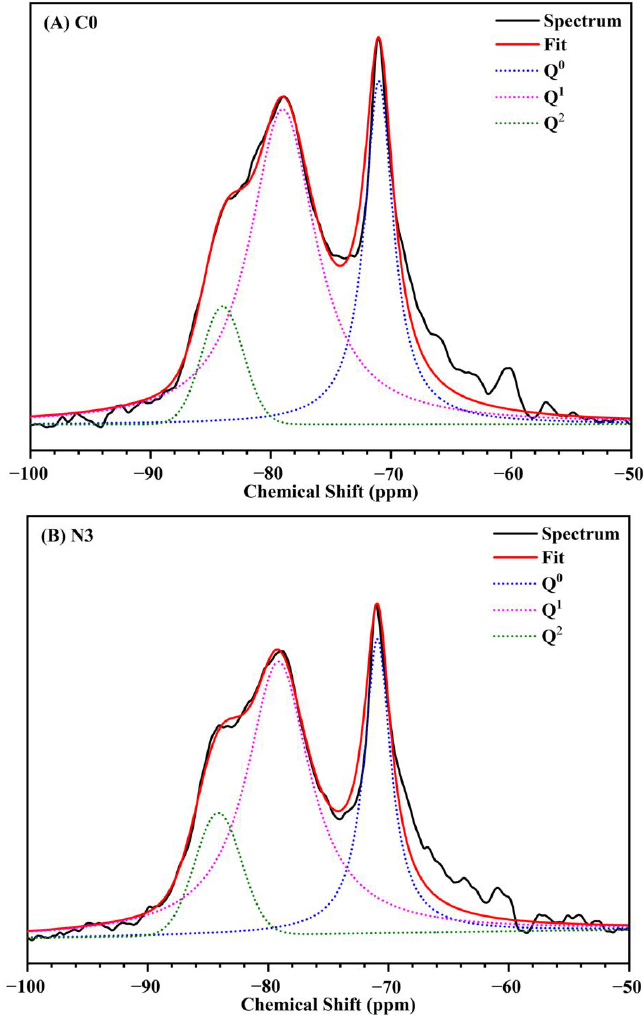
Figure 17. CH content of different cement pastes.